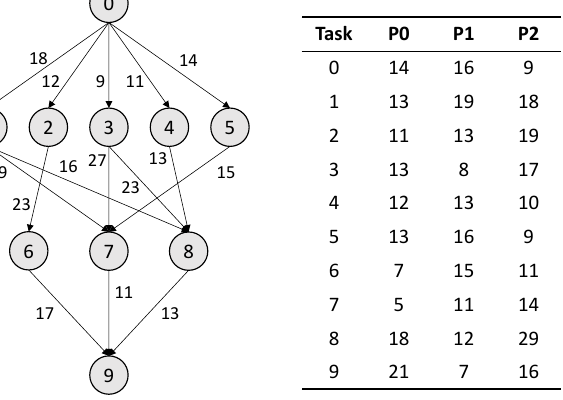
Figure 2. A diagram showing a canonical job and resource profiles [1]. This job consists of 10 tasks, and 3 resources support all tasks. On the left figure, nodes represent tasks and edges represent communication costs. The right table describes execution time for supporting functionalities on each processor. A more complicated WiFi profile is described in Appendix A.